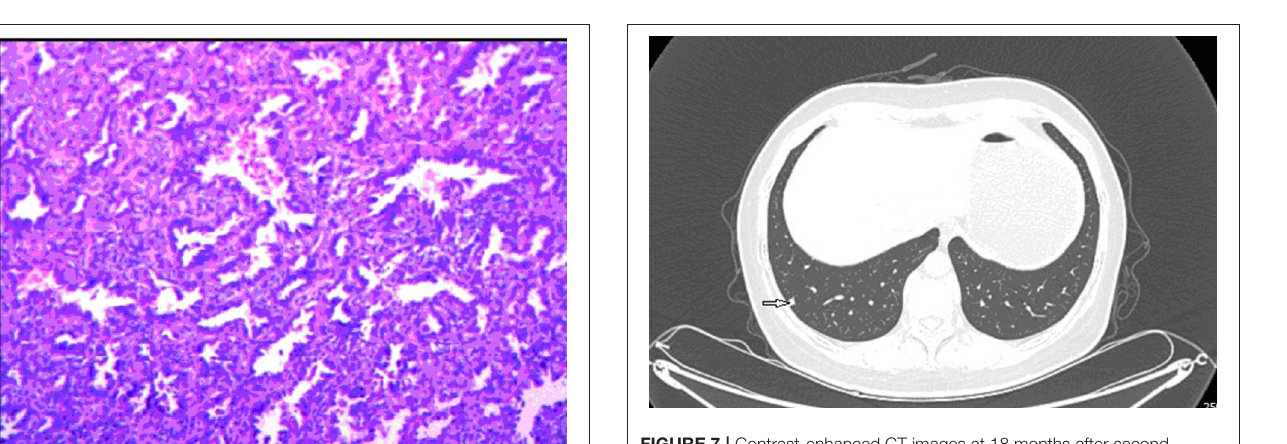
FIGURE 7 | Contrast-enhanced CT images at 18 months after second surgery: lump in lower lobe of the right lung.